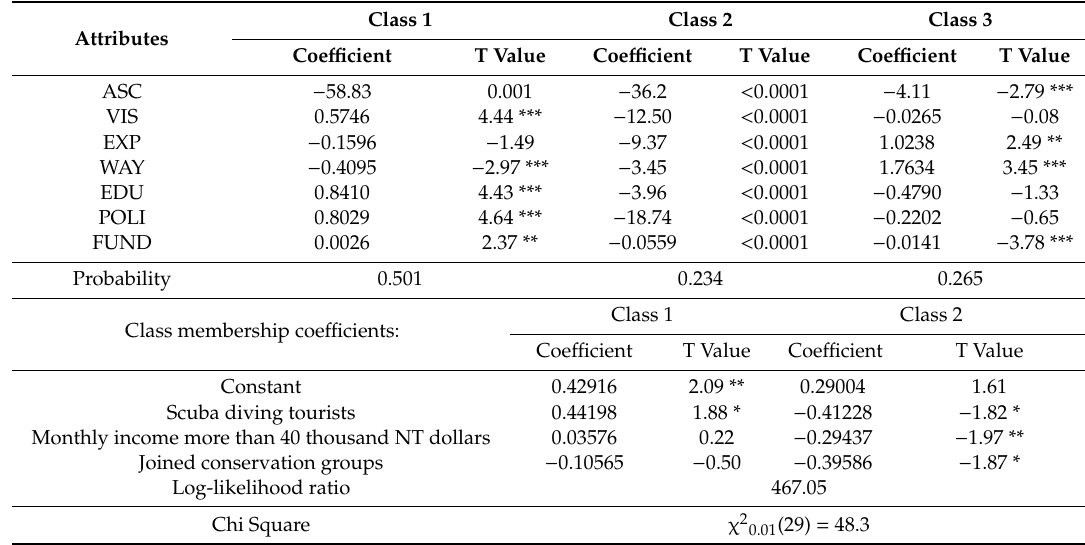
Table 4. Estimated coe ffi cients from latent class model (LCM)